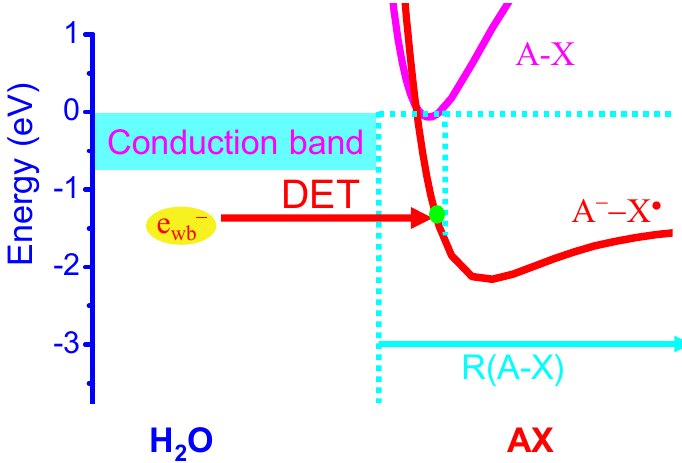
Figure 4. Schematic diagram for the dissociative electron transfer (DET) reaction [18,19,49,50] of a halogenated aromatic ring molecule AX with a weakly ‐ bound electron (e wb − ) in phagosomes, where e wb − is readily donated from a variety of enzymes or antioxidants or O 2• − . For HCQ and chloroquine, A is a quine ring system and X = Cl, whereas A is an aromatic ring coupled to two NH 2 groups at ortho positions [A = B(NH 2 ) 2 ] and X = Cl n or Br n or I n with n = 1,2 for FMD compounds) [69,70].